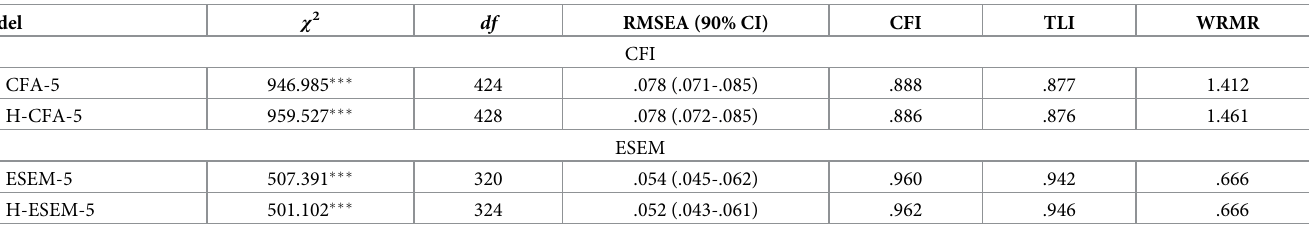
Table 1. Fit values for the QCAE CFA and ESEM models tested in the study.